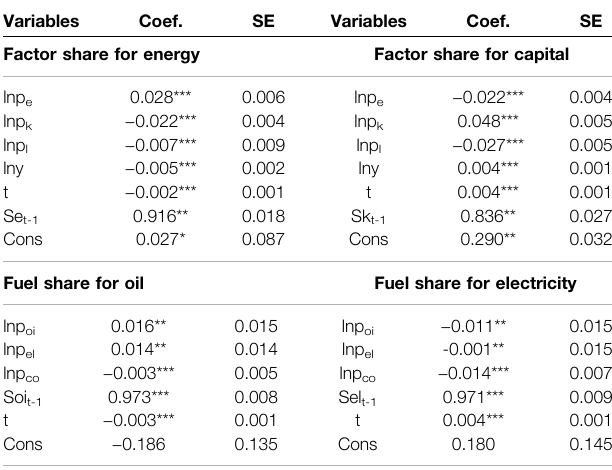
TABLE 1 | The estimating results in factor and fuel share equations in the EIIs. Variables Coef. SE Variables Coef.